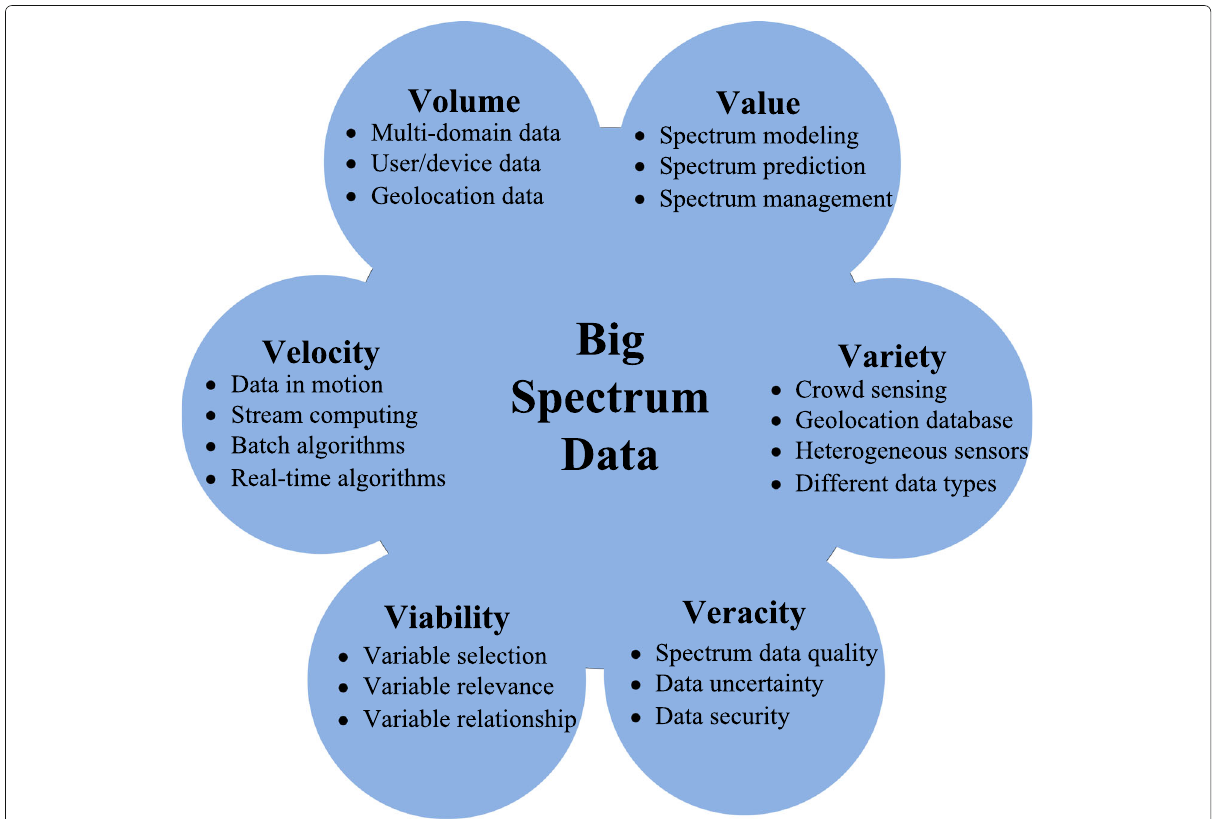
Fig. 3 Key characteristics of big spectrum